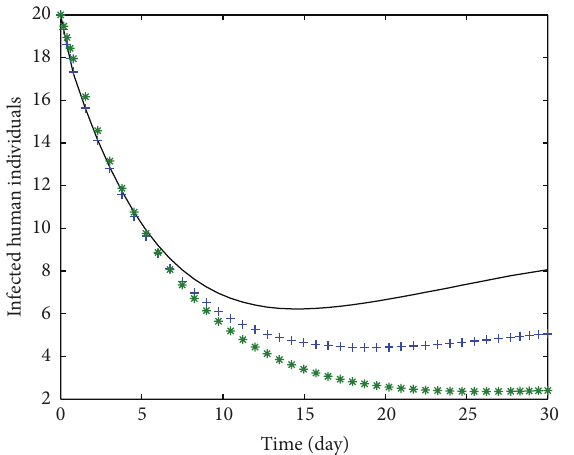
Figure 10: Infected vector: solid line (𝛼 = 1.0 , ++ line (𝛼 = 0.95) , and ∗∗ line (𝛼 = 0.90)